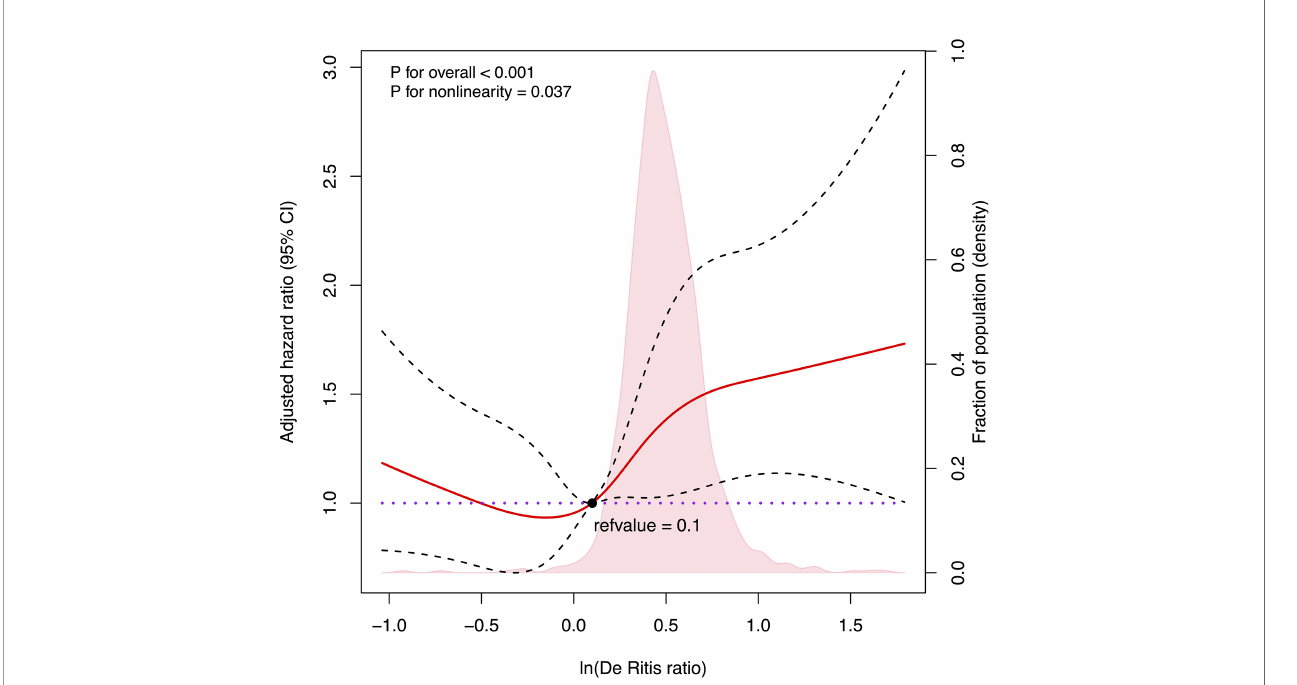
FIGURE 2 | Cubic spline plot of the association between the natural logarithm of De Ritis ratio and the overall survival among patients with hepatocellular carcinoma undergoing hepatectomy. The solid red line and black dashed line represent the multivariable-adjusted hazard ratios and their corresponding 95% CIs derived from restricted cubic spline regressions with fi ve knots. Pink shade shows fraction of population with different levels of De Ritis ratio. The black solid dot (refvalue = 0.1) indicates the natural logarithm of De Ritis ratio level with a risk of death of 1.0. Reference lines for no association are indicated by the purple dot-dashed line at a hazard ratio of 1.0. Analyses were adjusted for Barcelona Clinic Liver Cancer stage, albumin – bilirubin grade, cancer thrombus, tumor capsule, and hepatitis B virus DNA. ln(De Ritis ratio), the natural logarithm of aspartate transaminase/alanine transaminase